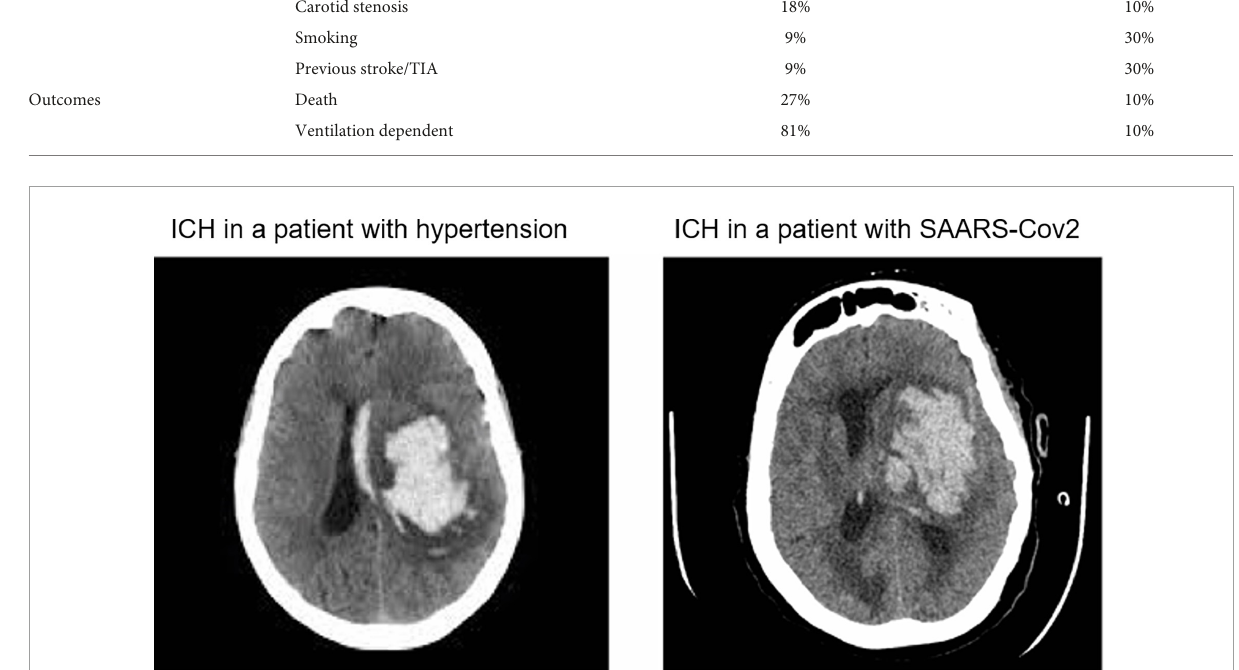
FIGURE1 Representative computed tomography (CT) scans of patients with intracranial hemorrhage (ICH) suffering from hypertension or SARS-CoV2